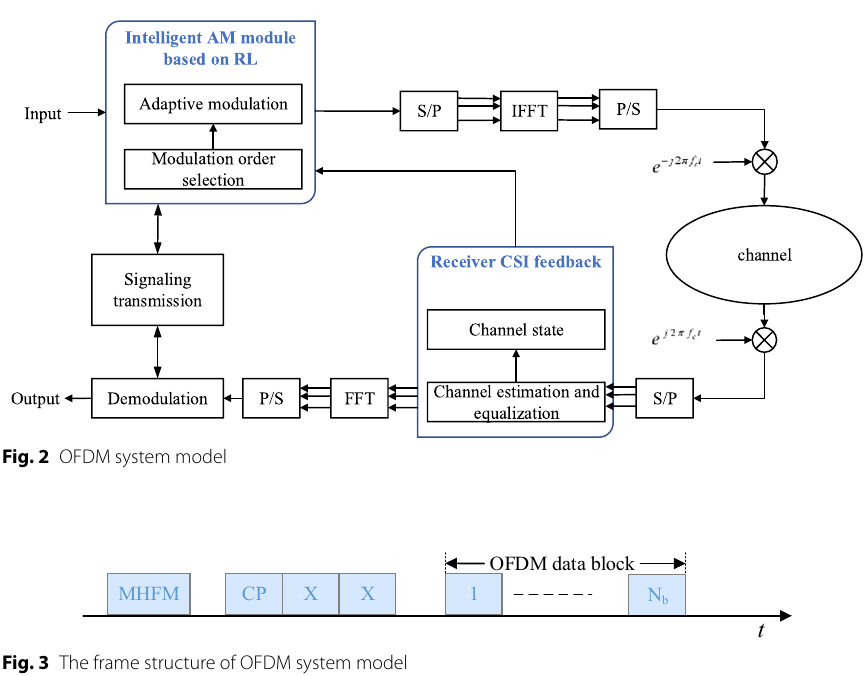
Fig. 3 The frame structure of OFDM system